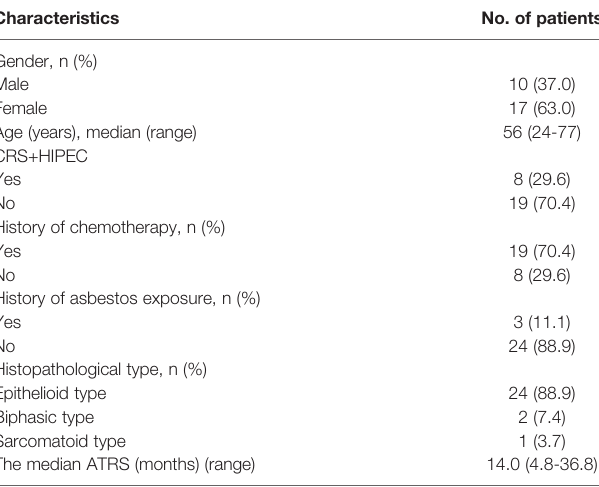
TABLE 1 | Major clinicopathological characteristics of 27 patients with refractory. Characteristics